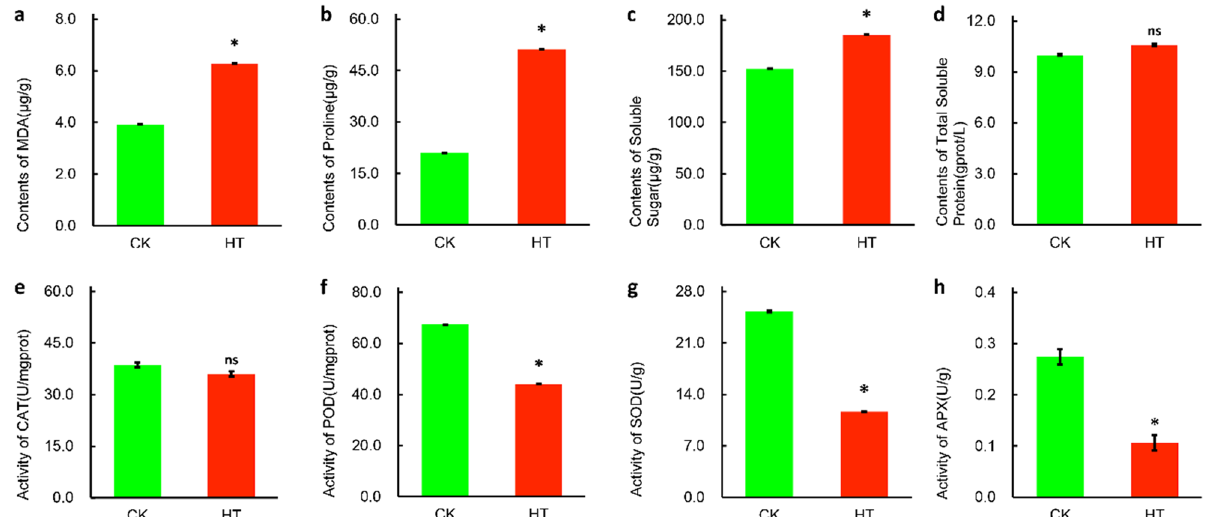
Figure 2. Physiological and biochemical indexes of leaves of S. pahuashanensis under heat stress. ( a ) MDA, ( b ) Pro, ( c ) Soluble sugar, ( d ) Total soluble protein, ( e ) CAT, ( f ) POD, ( g ) SOD and ( h ) APX (* indicate the significant difference at 5% levels according to student’s t-test, respectively. NS means no significant